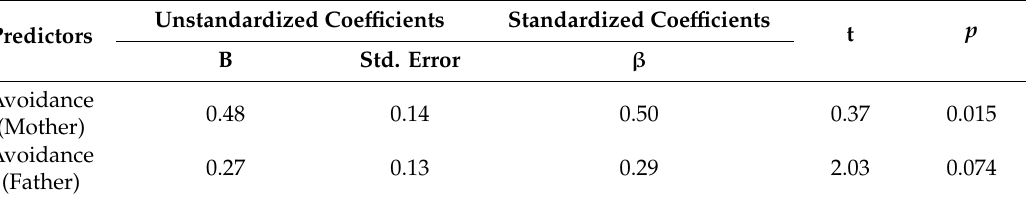
Table 2. MRA coe ffi cients of the contribution of attachment to each of the parents to avoidance in regard to attachment to the partner *.